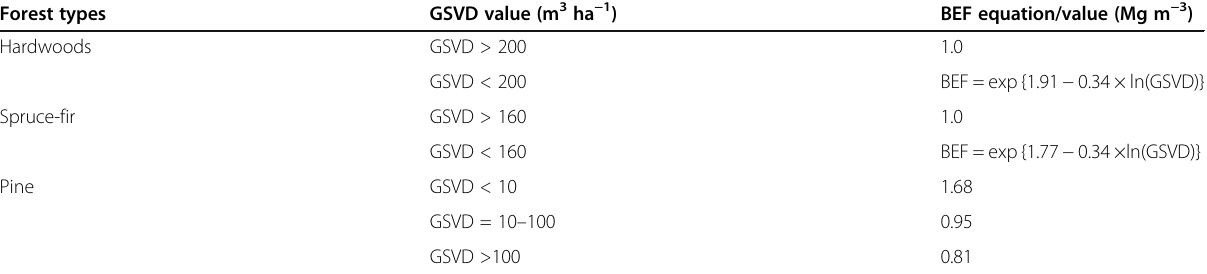
Table 3 Biomass expansion factor (BEF) values/regression equations and belowground biomass density (BGBD) regression equation Forest types